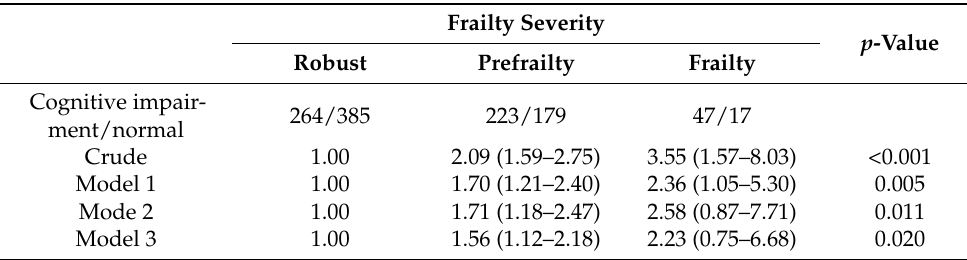
Table 3. Cognitive impairment risks with frailty severity in older adults by logistic regression in the 2014–2016 Nutrition and Health Survey in Taiwan.